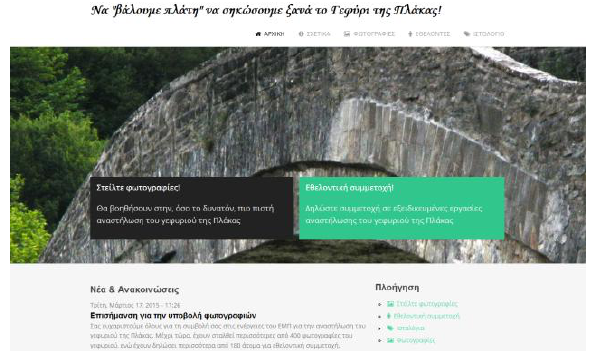
Figure 4: Home page of the crowdsourcing webpage.